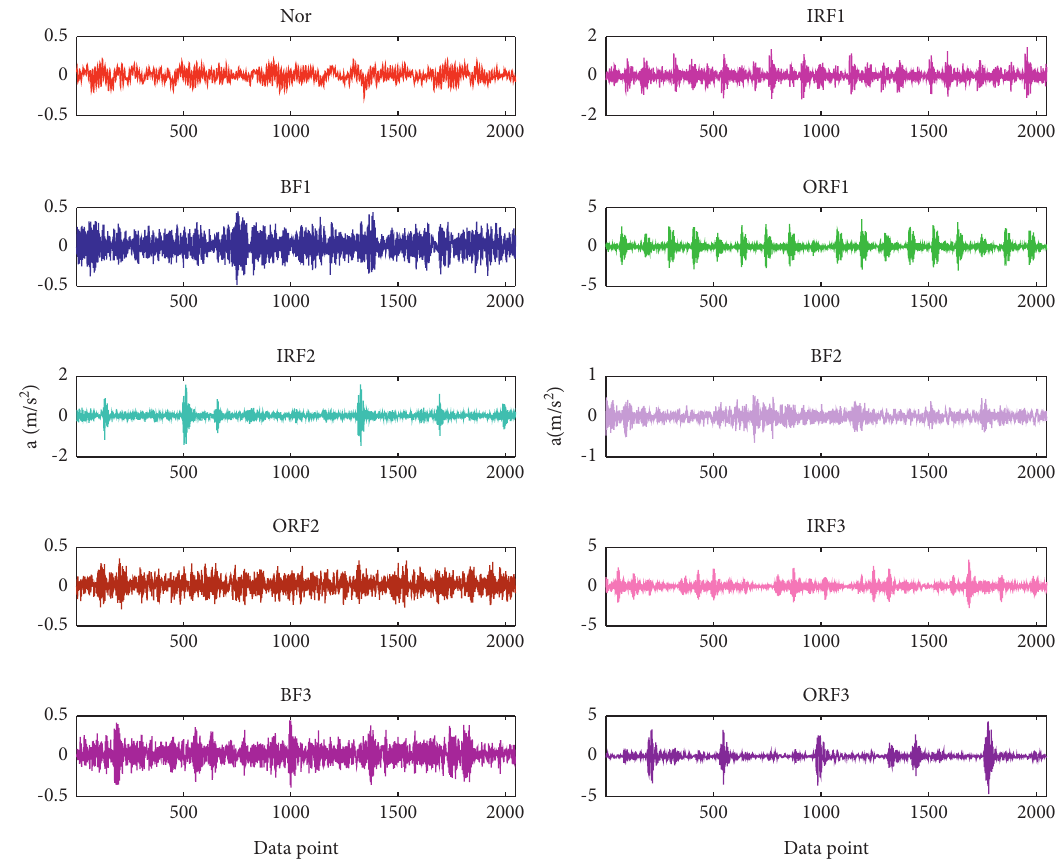
Figure 8: The vibration waveform of rolling bearing under ten fault conditions.